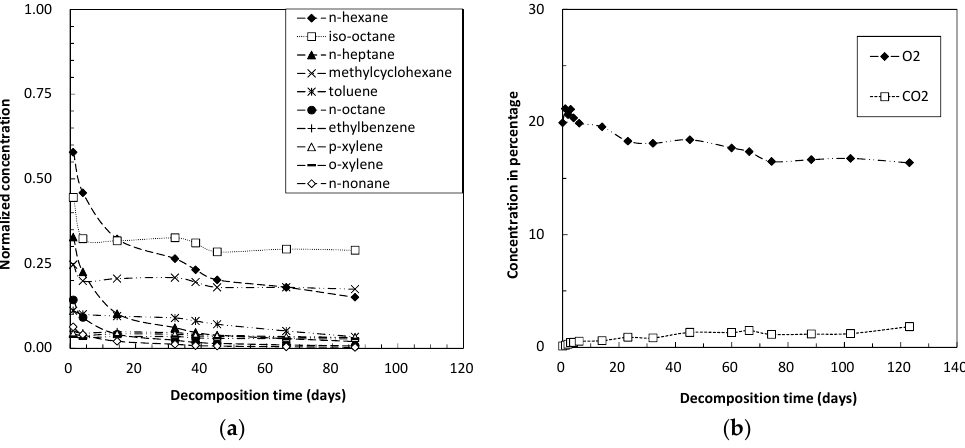
Figure 4. Concentrations over time of ( a ) organic and ( b ) inorganic gases during decomposition tests in polluted